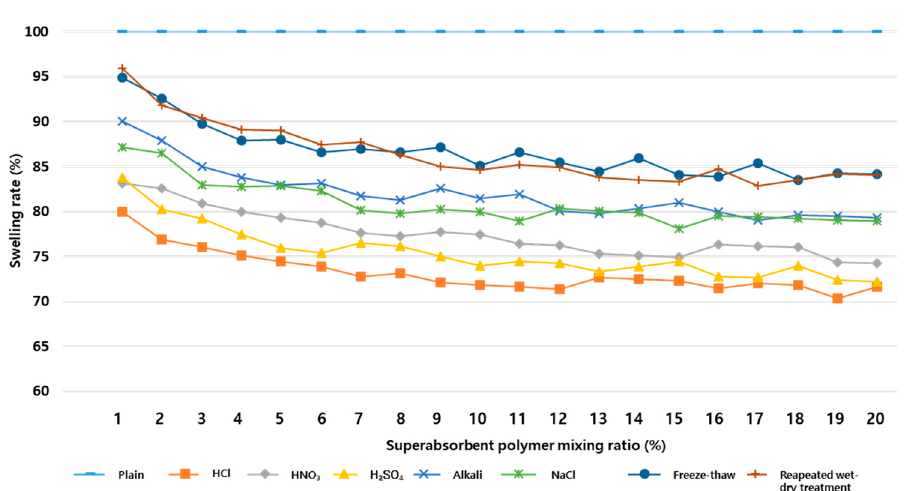
Figure 14. The analysis of the degree of the decrease in the swelling rate according to the deterioration conditions for each superabsorbent polymer content.